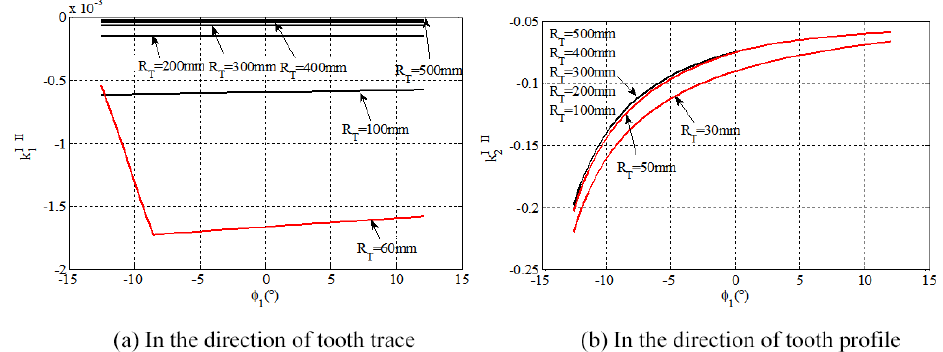
Figure 9. Effect of cutter radius on induced normal curvature profile.